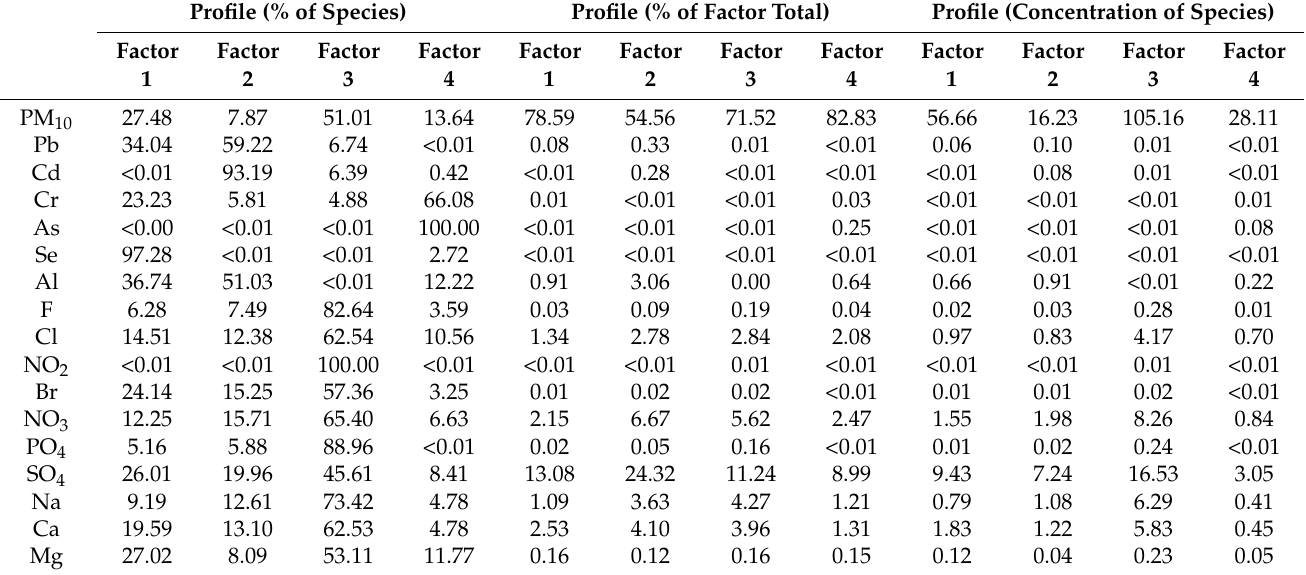
Table 2. Results of the positive matrix factorization run 3 (the convergent run), showing profile % of species, % of factor total and concentrations of species in each factor (factor 1 to factor